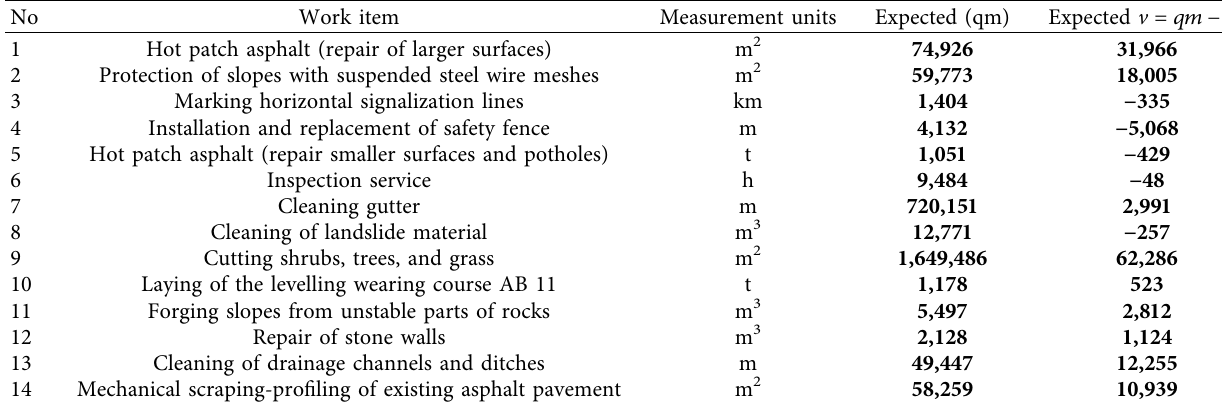
Table 5: Expected values of q